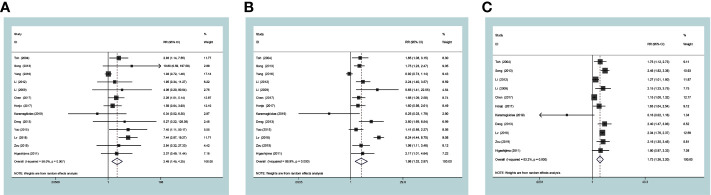
Forest plots of risk ratios for associations of metastasis-associated protein 1 (MTA1) with 1-year overall survival (OS) (A), 3-yearOS (B) and 5-yearOS (C) in the gastrointestinal cancer (GIC) patients.